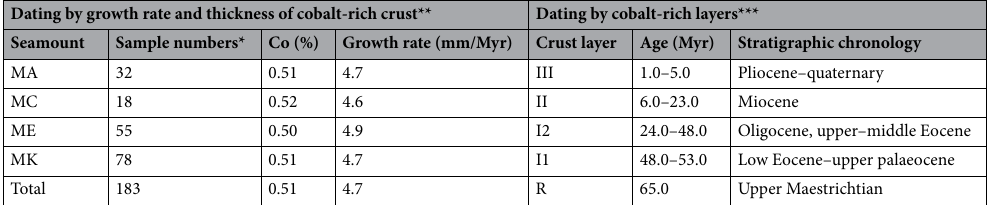
Table 2. Stratigraphic chronology of cobalt-rich crusts on the Magellan Seamounts. *Samples obtained through drilling shallow boreholes and dredging, whole rock analysis by absorption spectrometry. **Estimated by the formula of Puteanus and Halbach 49 . ***According to Melnikov and Pletnev 50 .